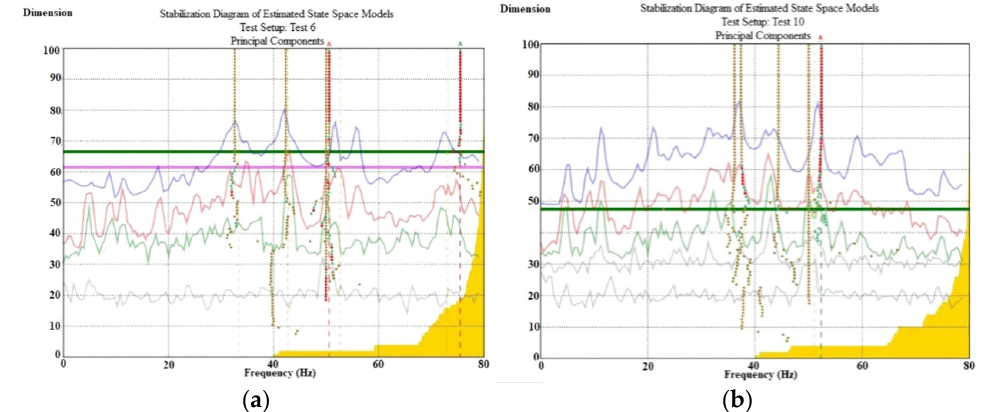
Figure 11. Stabilisation diagram of estimated state-space models of ( a ) test case 6—hammer impact; ( b ) test case 10—hammer impact. Table 4. Extracted natural frequencies using the SSI method.